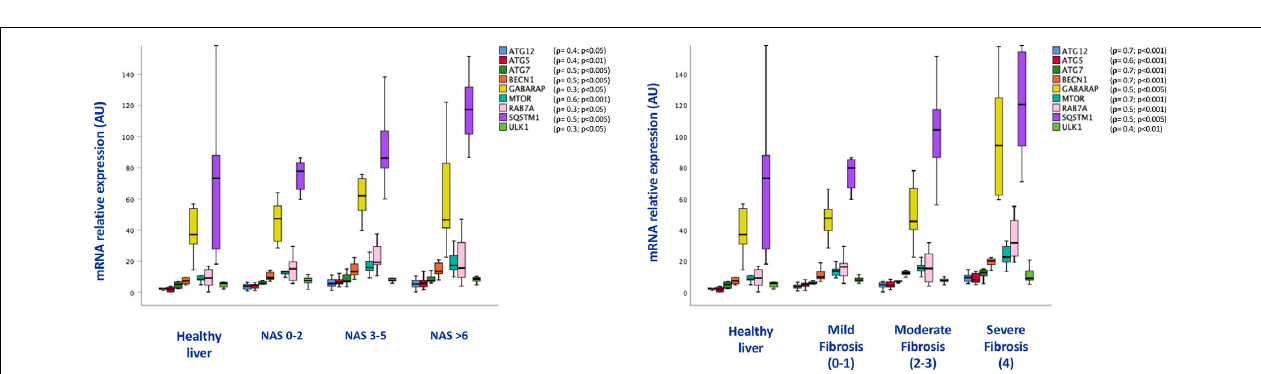
FIGURE 6 | Box plots of mRNA expression of autophagy related genes in association with NAS score (on the left ) and fibrosis stage (on the right ); ( n = 38). For correlation purpose Spearman’s ρ test was performed.